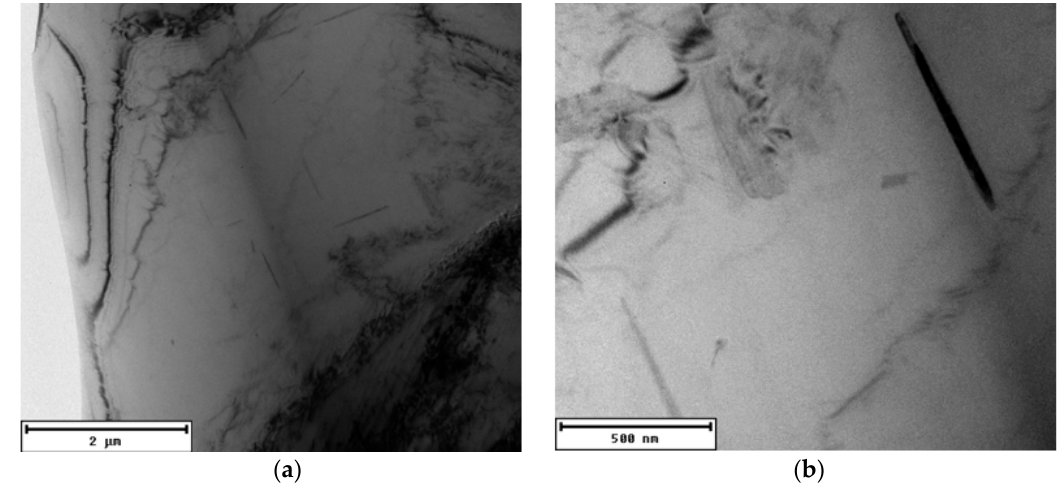
Figure 14. Substructure of 90–10 alloy after natural aging, TEM; ( a ) Overview ( b ) Detailed view